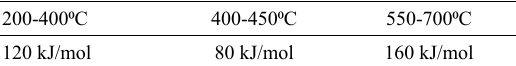
Figure 5. Temperature dependence of the average work hardening rate Δσ/Δε normalized by the elastic modulus E in AISI 304 steel. (0.5-5%) Table 3. Activation energies for the work hardening peaks in AISI 304